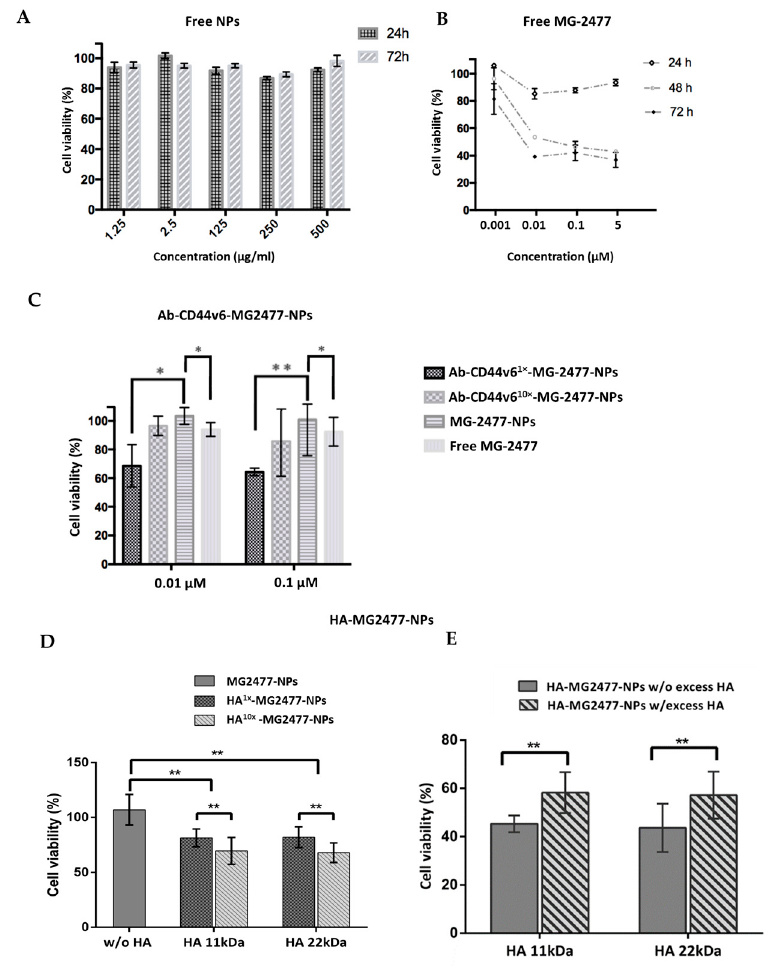
Figure 10. Cytotoxicity analysis of Ab-CD44v6-MG2477-NPs and HA-MG2477-NPs in HeLa-CD44v6 cells. ( A ) Analysis of the cytotoxicity of unconjugated and unloaded NPs (free NPs) by MTT assay. Unconjugated and unloaded NPs were incubated with cells at 37 °C for 4 h, after which the cells were washed to eliminate non-internalized NPs. At 24 and 72 h post-treatment, MTT assay was performed to measure cell viability. ( B ) Analysis of the cytotoxicity of free MG2477 by MTT assay. Cells were treated with free MG2477 for 24, 48, and 72 h, after which MTT assay was performed to measure cell viability. ( C ) Analysis of the cytotoxicity of Ab-CD44v6-MG2477-NPs loaded with MG-2477 and used to treat cells at two different concentration of drug (0.01 and 0.1 µM). NPs Ab-CD44v6 10x -MG2477-NPS and Ab-CD44v6 1x -MG2477-NPs, conjugated with a greater or a lower amount of antibody (ratio of NPs/antibody 1:10 and 1:1, respectively) were incubated with cells at 37 °C for 4 h, after which cells were washed to eliminate non-internalized NPs. At 72 h post-treatment, MTT assay was performed to measure cell viability; * p ≤ 0.05; ** p ≤ 0.01. ( D ) Analysis of the cytotoxicity of HA-MG2477-NPs, conjugated to two different molecular weights of HA (11.5 and 22.5 kDa) and to two different amount of HA (ratio of NPs/HA 1:10 and 1:1, respectively, HA 10x -MG2477-NPs and HA 1x -MG2477-NPs,), and used at a drug concentration of 0.1 µM. NPs were incubated with cells at 37 °C for 4h, after which cells were washed to eliminate non-internalized NPs. At 72 h post-treatment, MTT assay was performed; ** p < 0.01. ( E ) Competition assay of HA-MG2477-NPs conjugated to two different molecular weights of HA (11.5 and 22.5 kDa) used at a drug concentration of 0.1 µM and pretreated with an excess of HA. Cells were incubated for 1 h at 37 °C with (w/) or without (w/o) excess of HA (10 mg/mL in DMEM medium), washed, and then incubated with for 4 h. At 72 h post-treatment, cells were analyzed by the MTT assay; ** p < 0.01. The graphs shown represent the mean percentage of cell survival ±SD of experiments performed in triplicates. For statistical analysis, a Student’s T test was applied.